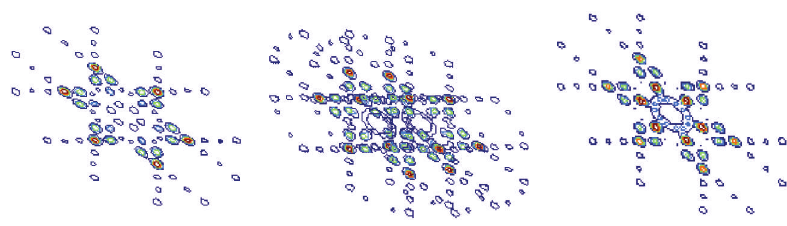
Figure 12: Bispectrum contour map of fault 4.